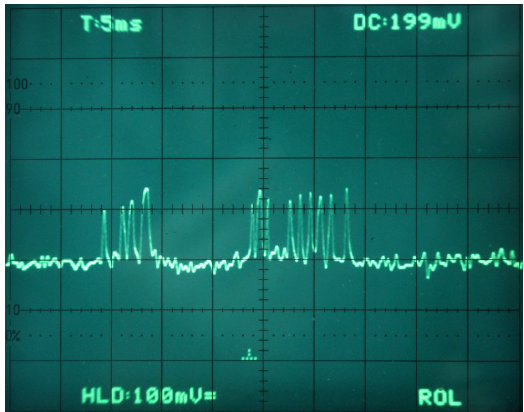
Figure 6. Power consumption of a patient’s device. To obtain the trace, we measured voltage drop on a 1 Ohm shunt resistor in series with batteries: 1 mV on the trace corresponds to 1